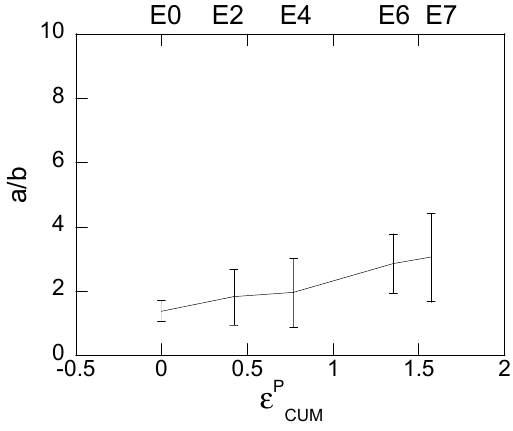
Figure 8. Shape factor evolution for hard -type inclusions.